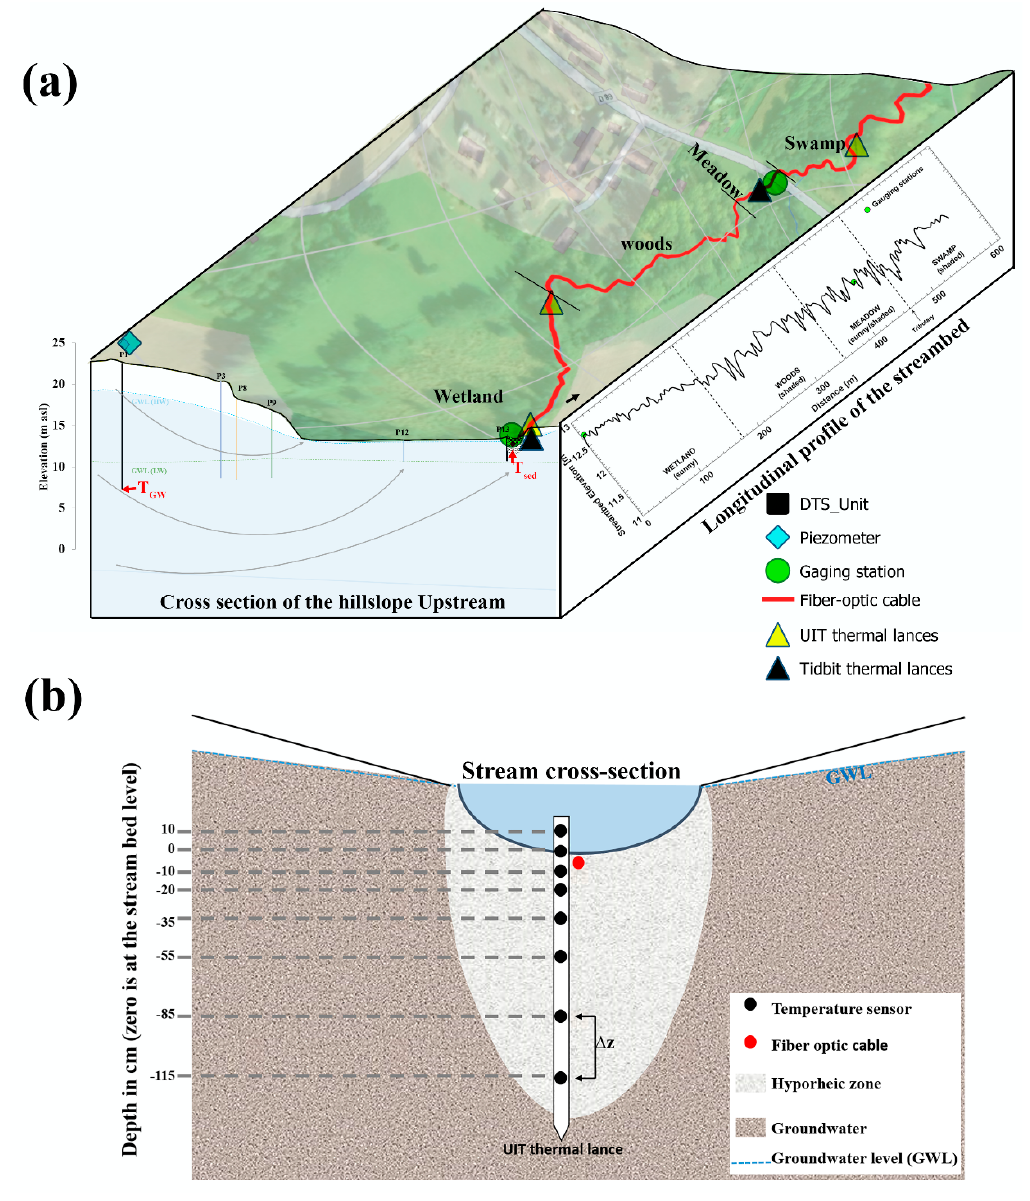
Figure 1. 3D view of the study area indicating the hillslope cross section and longitudinal profile. ( a ) Black lines indicate boundaries between sub-reaches with different geomorphologies. The blue diamond indicates the piezometer used to measure groundwater temperature (Tgw) and groundwater level (GWL, dashed blue line). ( b ) Stream cross section showing Umwelt-und Ingenieurtechnik (UIT) lance temperature sensors and depth in the hyporheic zone. ∆ z is the distance between two sensors used to calculate flow at a groundwater inflow point and a neutral (non-inflow) point, respectively.